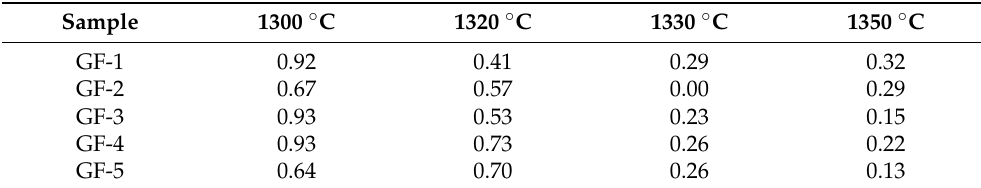
Table 8. Content of f -CaO in HBSC clinker sintering at different temperatures (%).